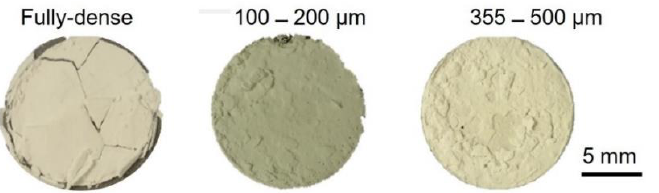
Figure 2. Macro-images of the fully-dense and two pores ’ range sizes (100 – 200 and 355 – 500 µm) acquired with an optical microscope.